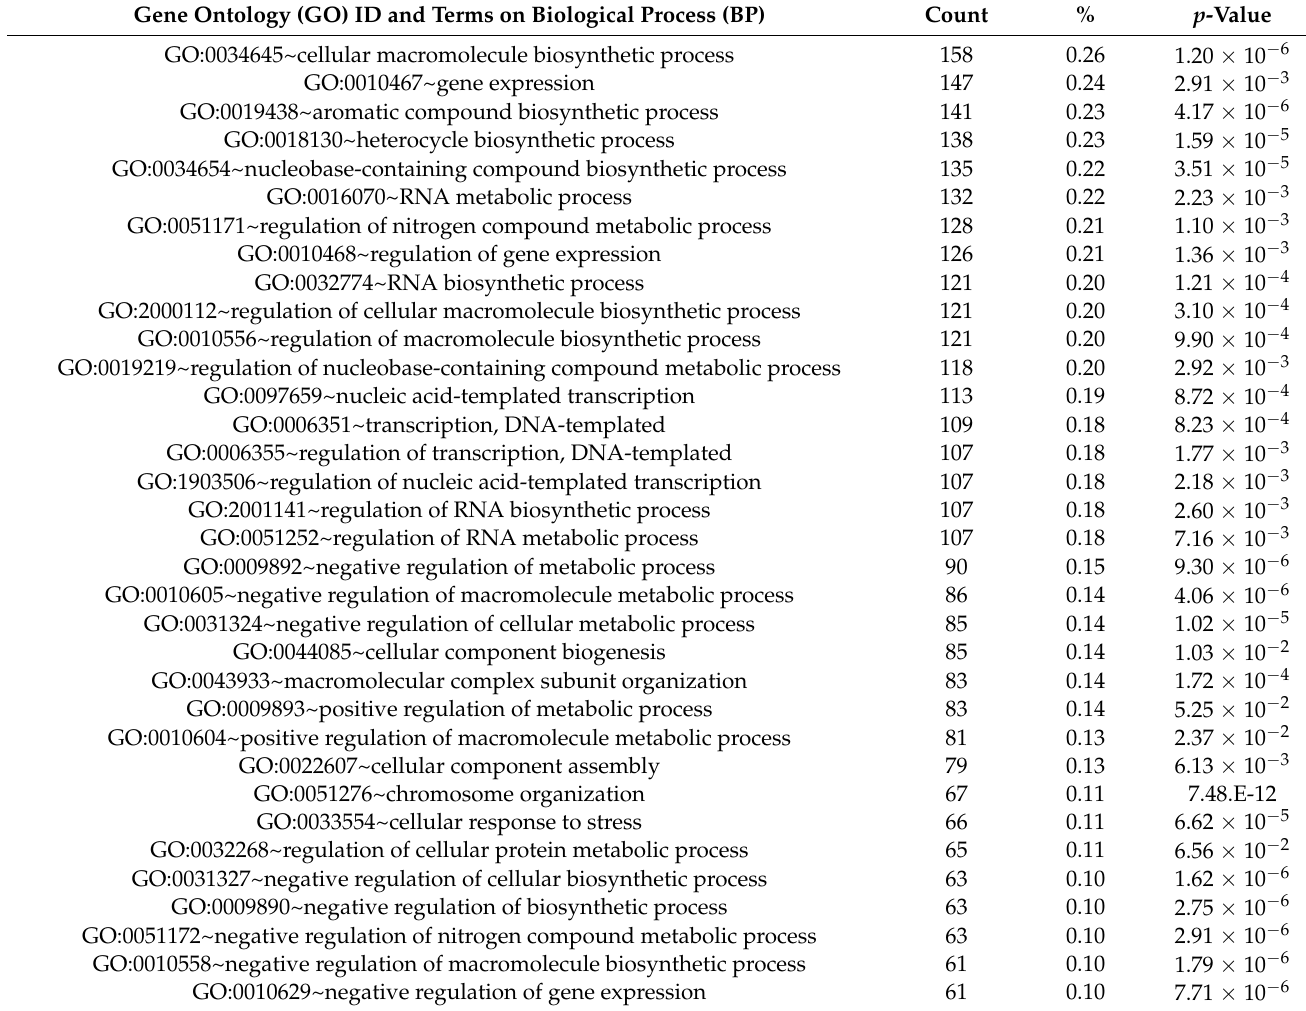
Table 6. The functional analysis of the downregulated genes at 6 h after LLL